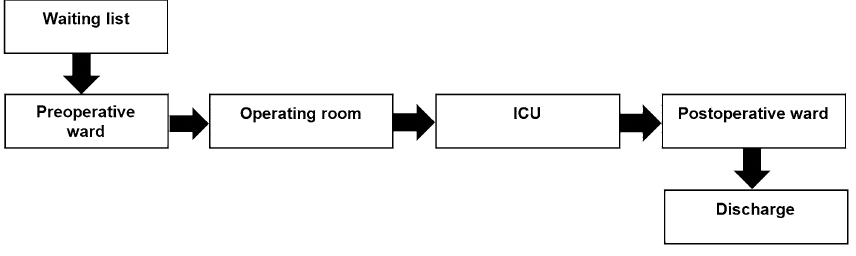
Figure 1. Demonstration of patient flow in the cardiac surgery department